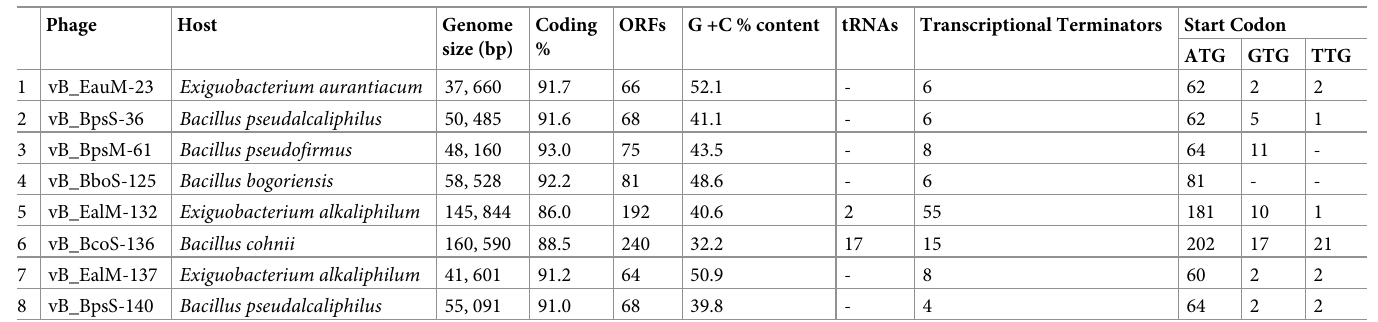
Table 1. The basic genomic features of the eight genome sequences of this study. Phage